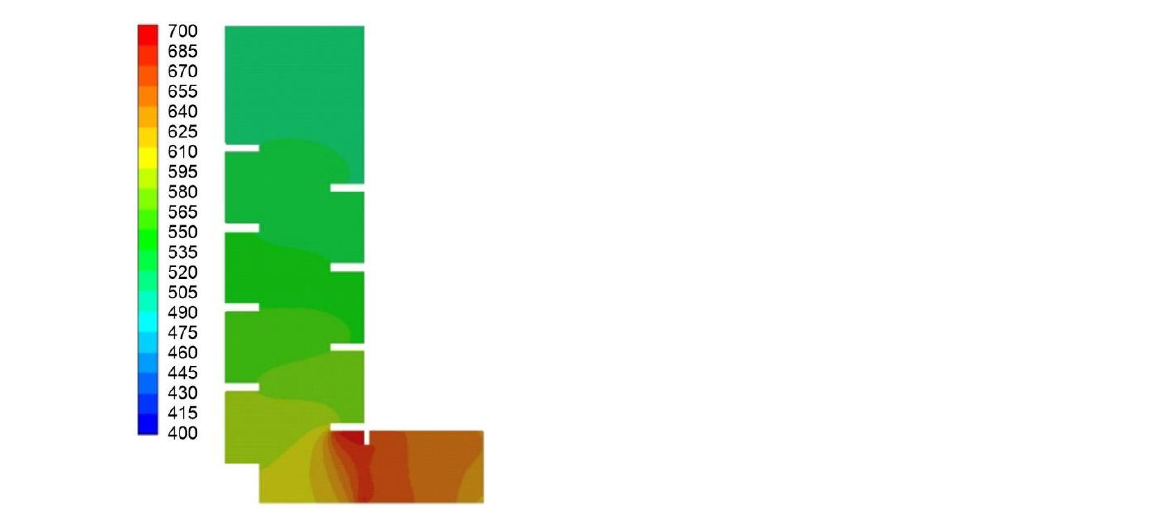
8 of 13 Figure 7. Carbon dioxide distribution for a closed building. Carbon dioxide was measured as a mass fraction. The highest temperature value and volume concentration of carbon dioxide were